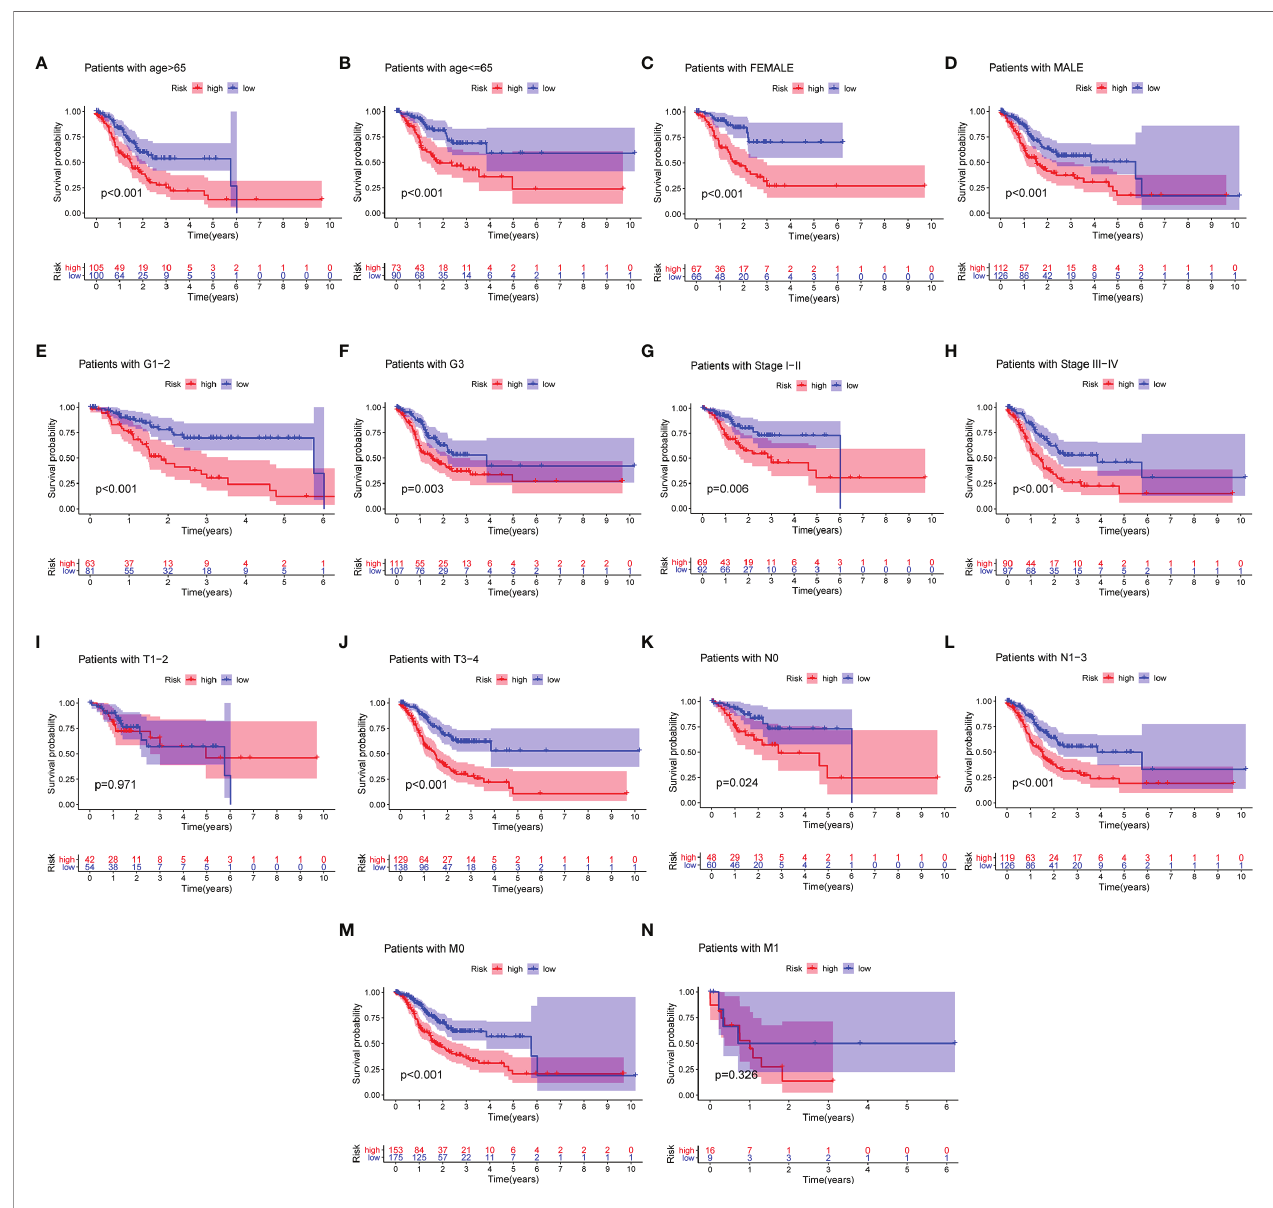
FIGURE 4 | Differential survival outcomes of GC in the clinical subgroup. (A – N) Kaplan – Meier curves for age (A, B) , gender (C, D) , grade (E, F) , stage (G, H) , T (I, J) , N (K, L) , and M (M, N)